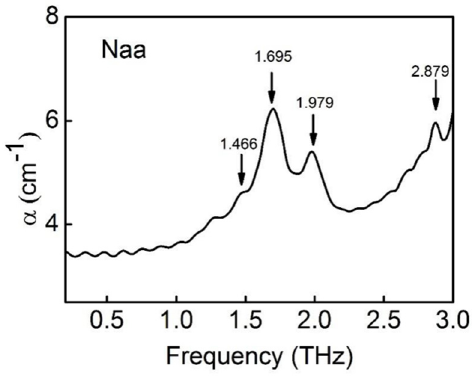
Figure 14. Terahertz spectrum of N-acetylaspartate (NAA) (courtesy of Y. Peng).